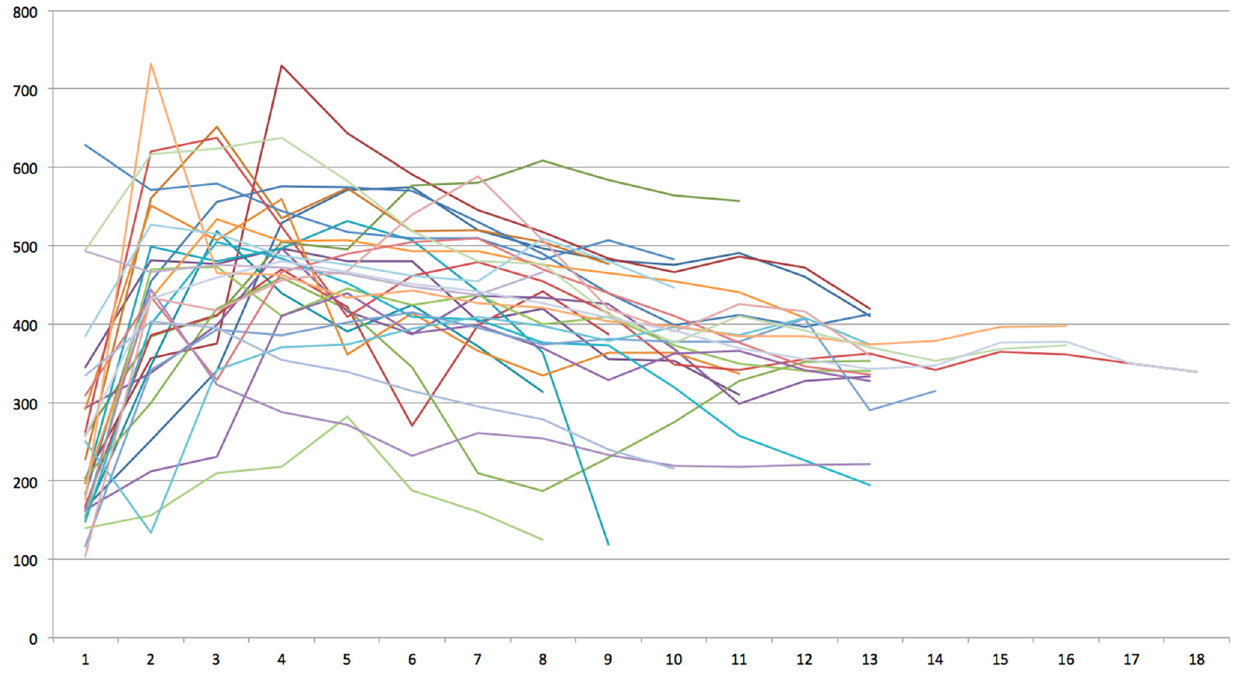
Figure 3. Bone density measurements of 32 transcrestal sinus bone grafts after 4 months of healing yielded between 104 and 755 Houndsfield Units (HU) in 1–18 mm distance to the sinus